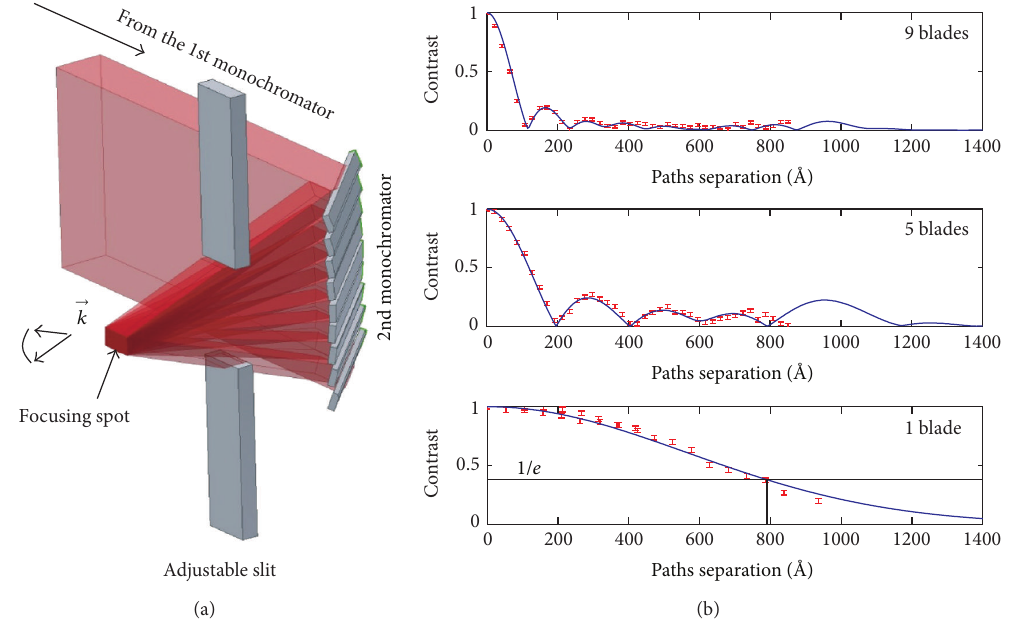
Figure 3: (a) Schematic of the second focusing PG monochromator for shaping the vertical momentum distribution of the neutron beam. By shielding some of the blades of the monochromator we can select different neutron momentum distributions. (b) Contrast versus path separations for different momentum distributions. The top figure is obtained when 9 blades of the 2nd monochromator are open, the middle figure when 5 middle blades are open, and the bottom figure when only one middle blade is open [14].